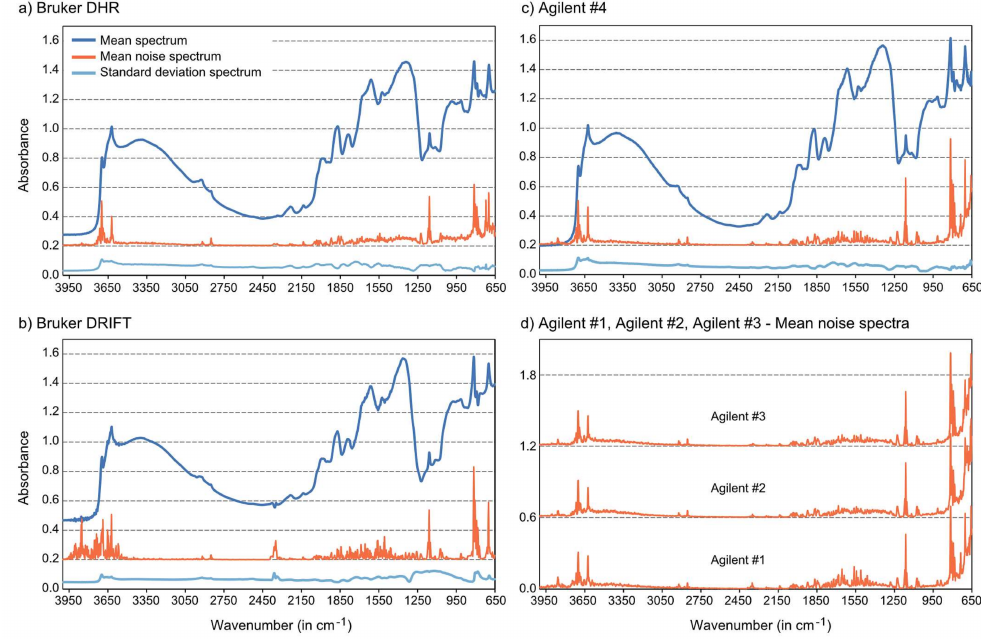
Figure 3. Characteristics of the measured spectra. ( a – c ) Mean, noise and standard deviation spectra for Bruker ( a , b ) and composite Agilent (#4) ( c ) data (noise values multiplied by a factor of ten and with an offset of 0.2 for clarity), ( d ) Noise spectra of all three individual Agilent measurement series (multiplied by a factor of ten and with an offset of 0.6 (Agilent #2) and 1.2 (Agilent #3),